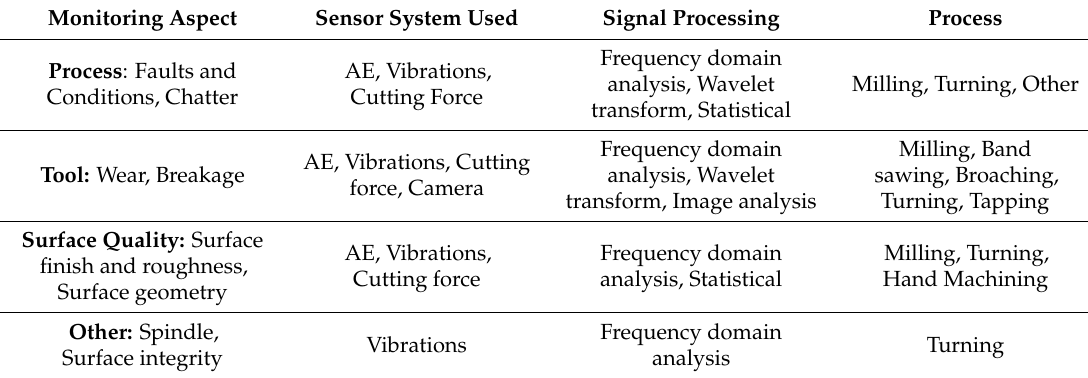
Table 1. Process monitoring using sensors classified based on the monitored